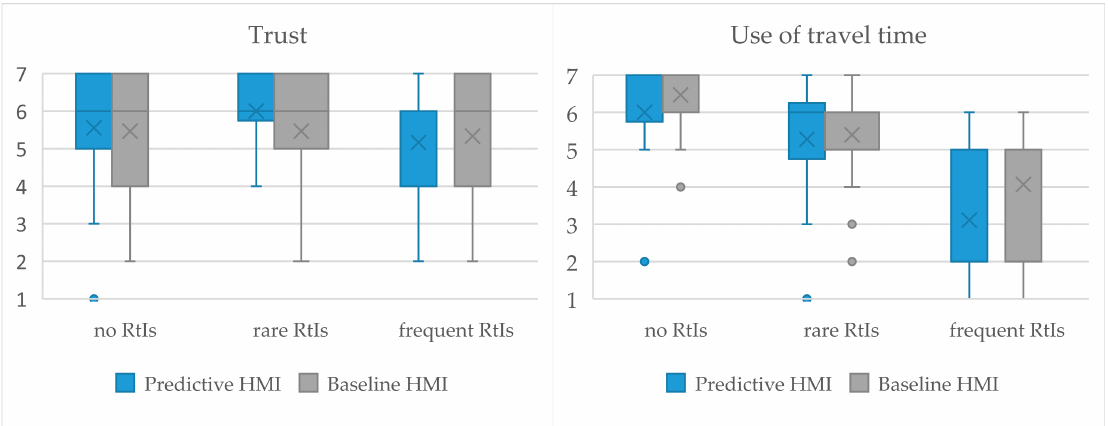
Figure 5. Boxplots for subjective use of travel time (7-Likert) and trust (7-Likert).